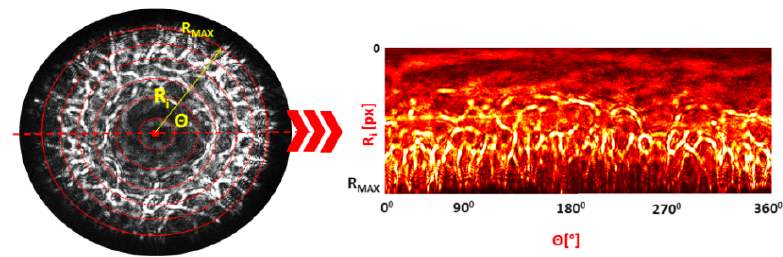
Figure 2. The schema of the proposed algorithm for the examination of the bacterial colony–illuminating beam misalignment influence on the spatial distribution of the Fresnel patterns (description in text).